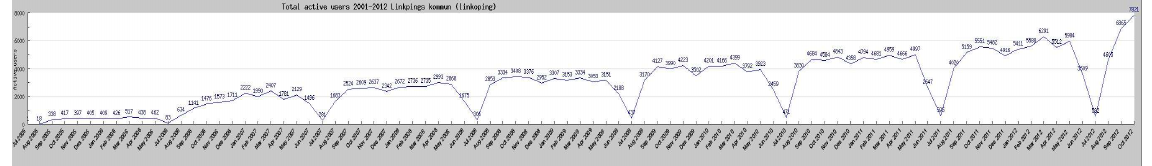
Figure 3. Total logins FRONTER 2001-2012 (Linköping